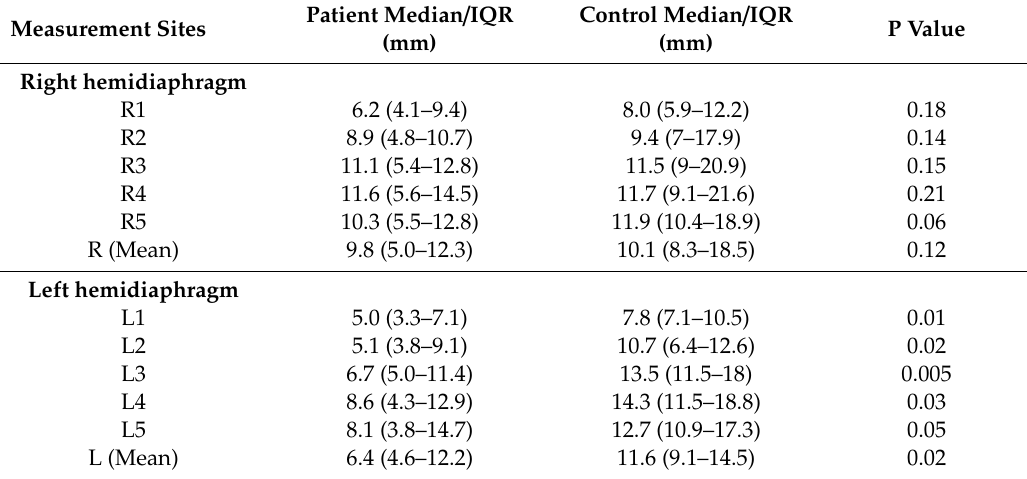
Table 3. Statistical